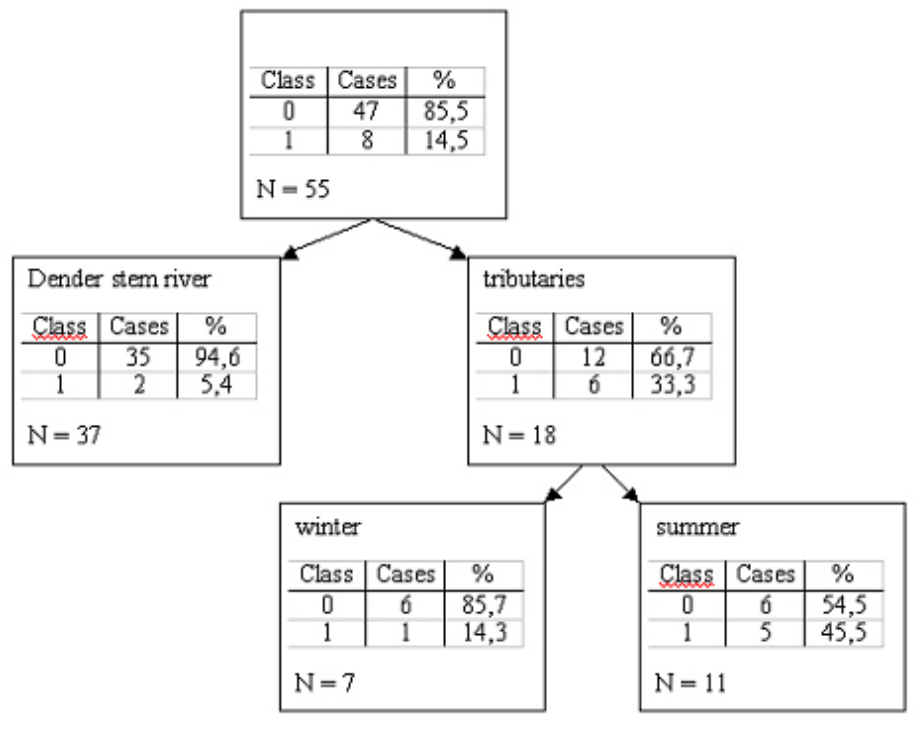
FIGURE 6. Classification tree for Mollusca with splitting variables (cid:147)river type(cid:148) (Dender stem river) and (cid:147)season(cid:148) (only summer and winter). (cid:147)N(cid:148) represents the total number of measuring cases that are present in a branch of the classification tree, divided over (cid:147)class 0(cid:148) (no Mollusca present) and (cid:147)class 1(cid:148). (Mollusca present, but not abundantly [< 100]). No class 2 cases (Mollusca abundantly present) were